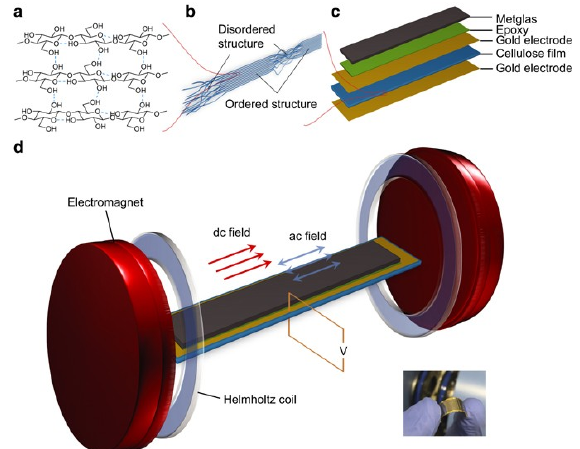
Figure 13. ( a ) The scheme of cellulose crystal II; ( b ) Illustration of cellulose fibril alignment at the cross-section of cellulose film; ( c ) Schematic of cellulose-based ME laminate structure; ( d ) Schematic view of the bulk system for ME voltage measurement. Reproduced with permission from [84] .